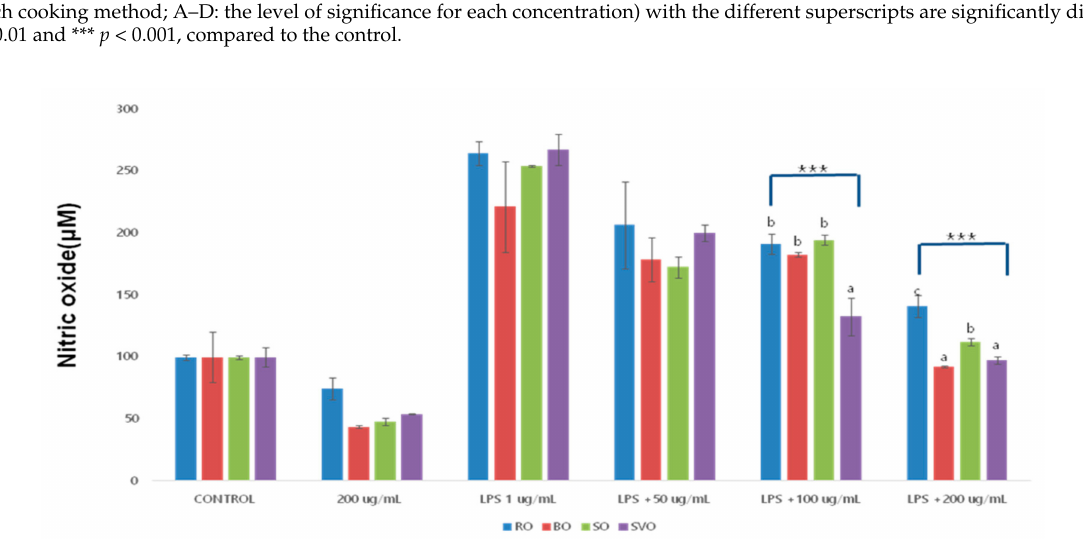
Figure 2. Cooking methods and okra extract on nitric oxide (NO) production in LPS-induced RAW264.7cells. Cells are treated with ROE, BOE, SOE, and SVOE (25, 50, 100, 200 µ g/mL), then with or without LPS (1 µ g/mL) for 24 h. The cultured supernatant of the treated cells were used to measure NO level. Each bar represents the mean ± SD. *** Significance of okra cooking method. Significant values are represented by a–c (*** p < 0.001) compared to the group treated LPS alone. NO: nitric oxide, LPS: lipopolysaccharide, ROE: raw okra ethanol extract, BOE: blanched okra ethanol extract, SOE: steamed okra ethanol extract, and SVOE: sous-vide cooked okra ethanol